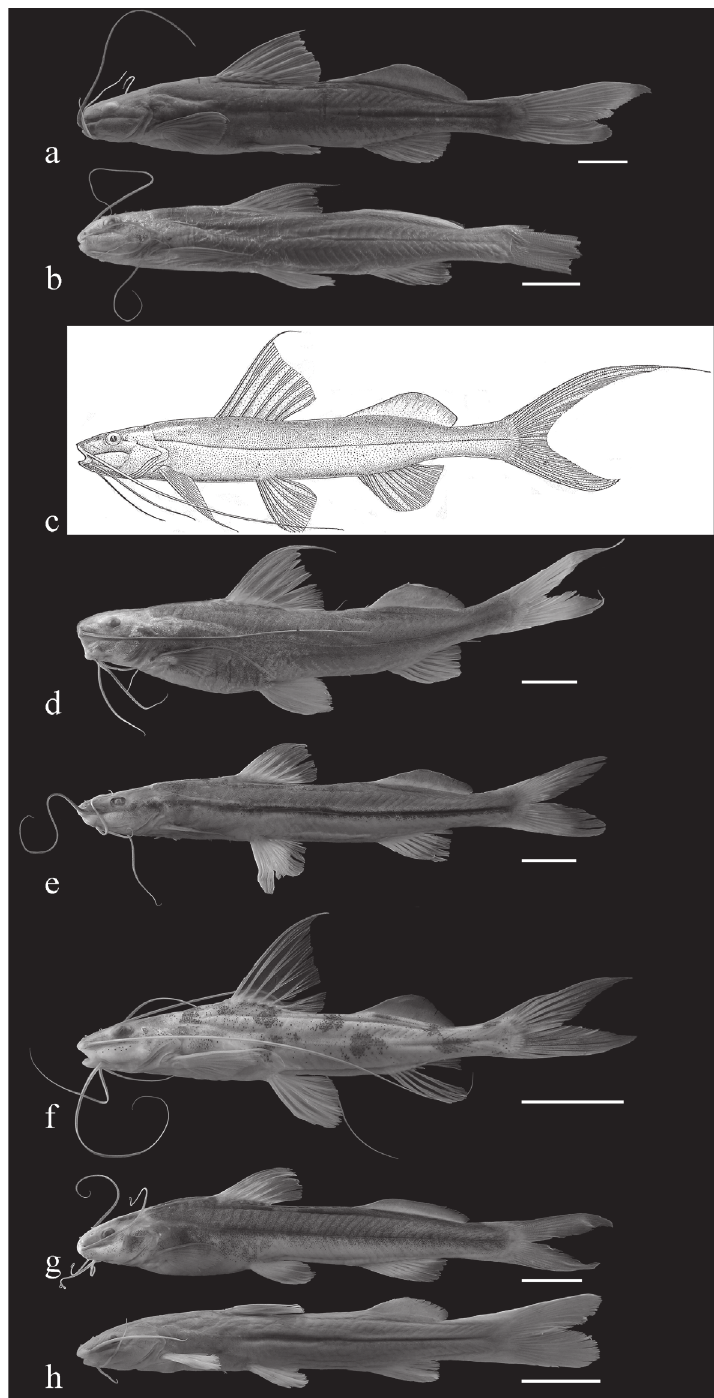
Fig. 5. Trans-Andean species of Imparfinis and I. pseudonemacheir from Venezuelan Orinoco basin. Scale bars 1 cm. ( a ) I. usmai , MBUCV-V-35640, 88.7 mm SL, Colombia, Valle del Cauca, Cartago, río La Vieja, Valle Cartago, upper río Cauca basin; ( b ) I. nemacheir , FMNH 58127 (ex CM 7125), 105.0 mm SL, holotype of Nannorhamdia nemacheir , photograph by M. Littmann, FMNH Division of Fishes; ( c ) I. nemacheir , holotype of N. nemacheir , illustration from Eigenmann (1922); ( d ) I. nemacheir , MHNLS 15453, 81.4 mm SL, Venezuela, Trujillo, río Pocó, Lago de Maracaibo basin; ( e ) I. spurrellii , ICN-MHN 5532, 82.0 mm SL, Colombia, Chocó, río San Juan; ( f ) I . pseudonemacheir , MBUCV-V-28656, 48.1 mm SL, Venezuela, Anzoategui, río Atapirire, where crossed by the road between Manasma and Atipirire, río Orinoco basin; ( g ) I. timana , IAvH-P 10696, 74.2 mm SL, holotype, Colombia, Huila, río Guarapas, in the mouth of quebrada La Quebradona, río Magdalena basin; ( h ) I. lineatus , MBUCV-V-32675, 69.4 mm SL, Costa Rica, Puntarenas, río Peje, 13 km S of San Isidro